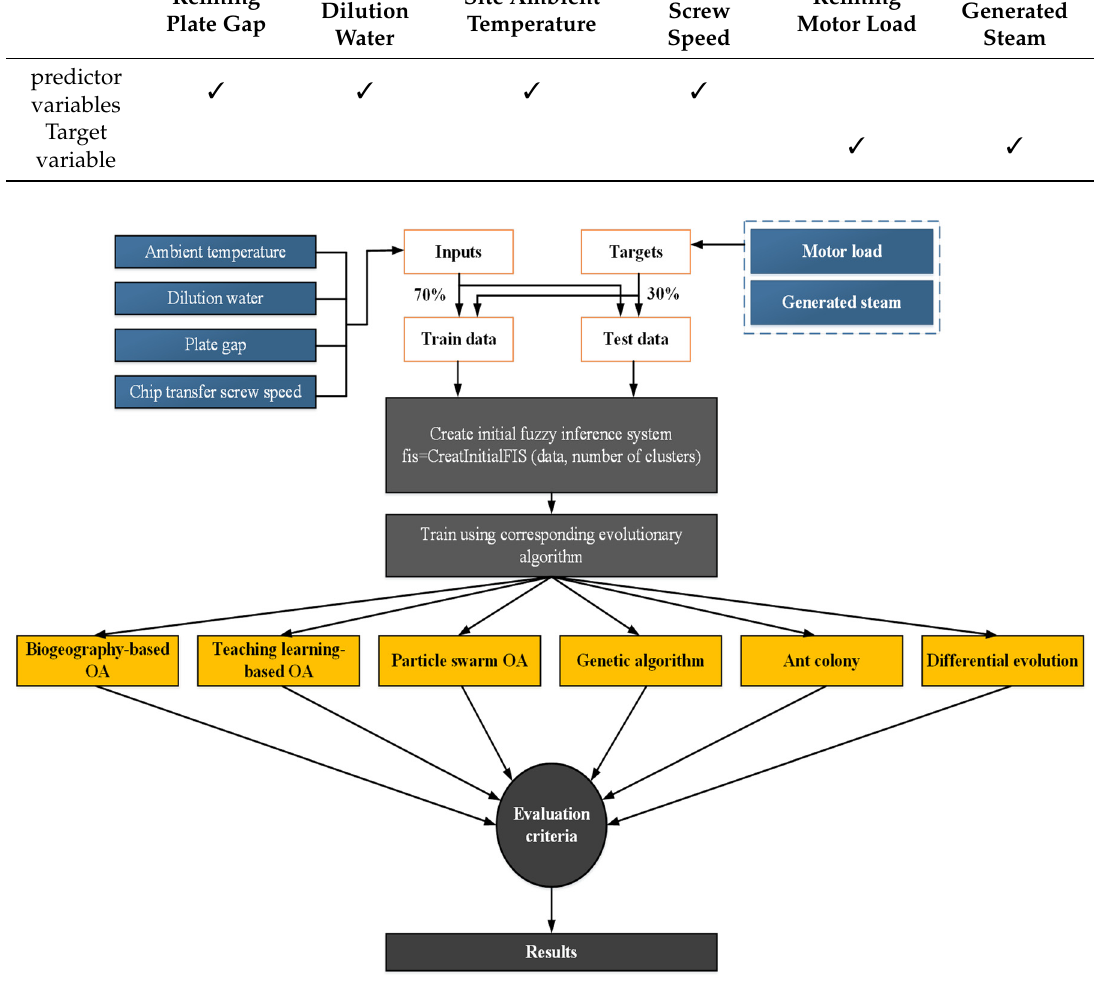
Figure 10. The structure of the proposed method for refining energy simulation.